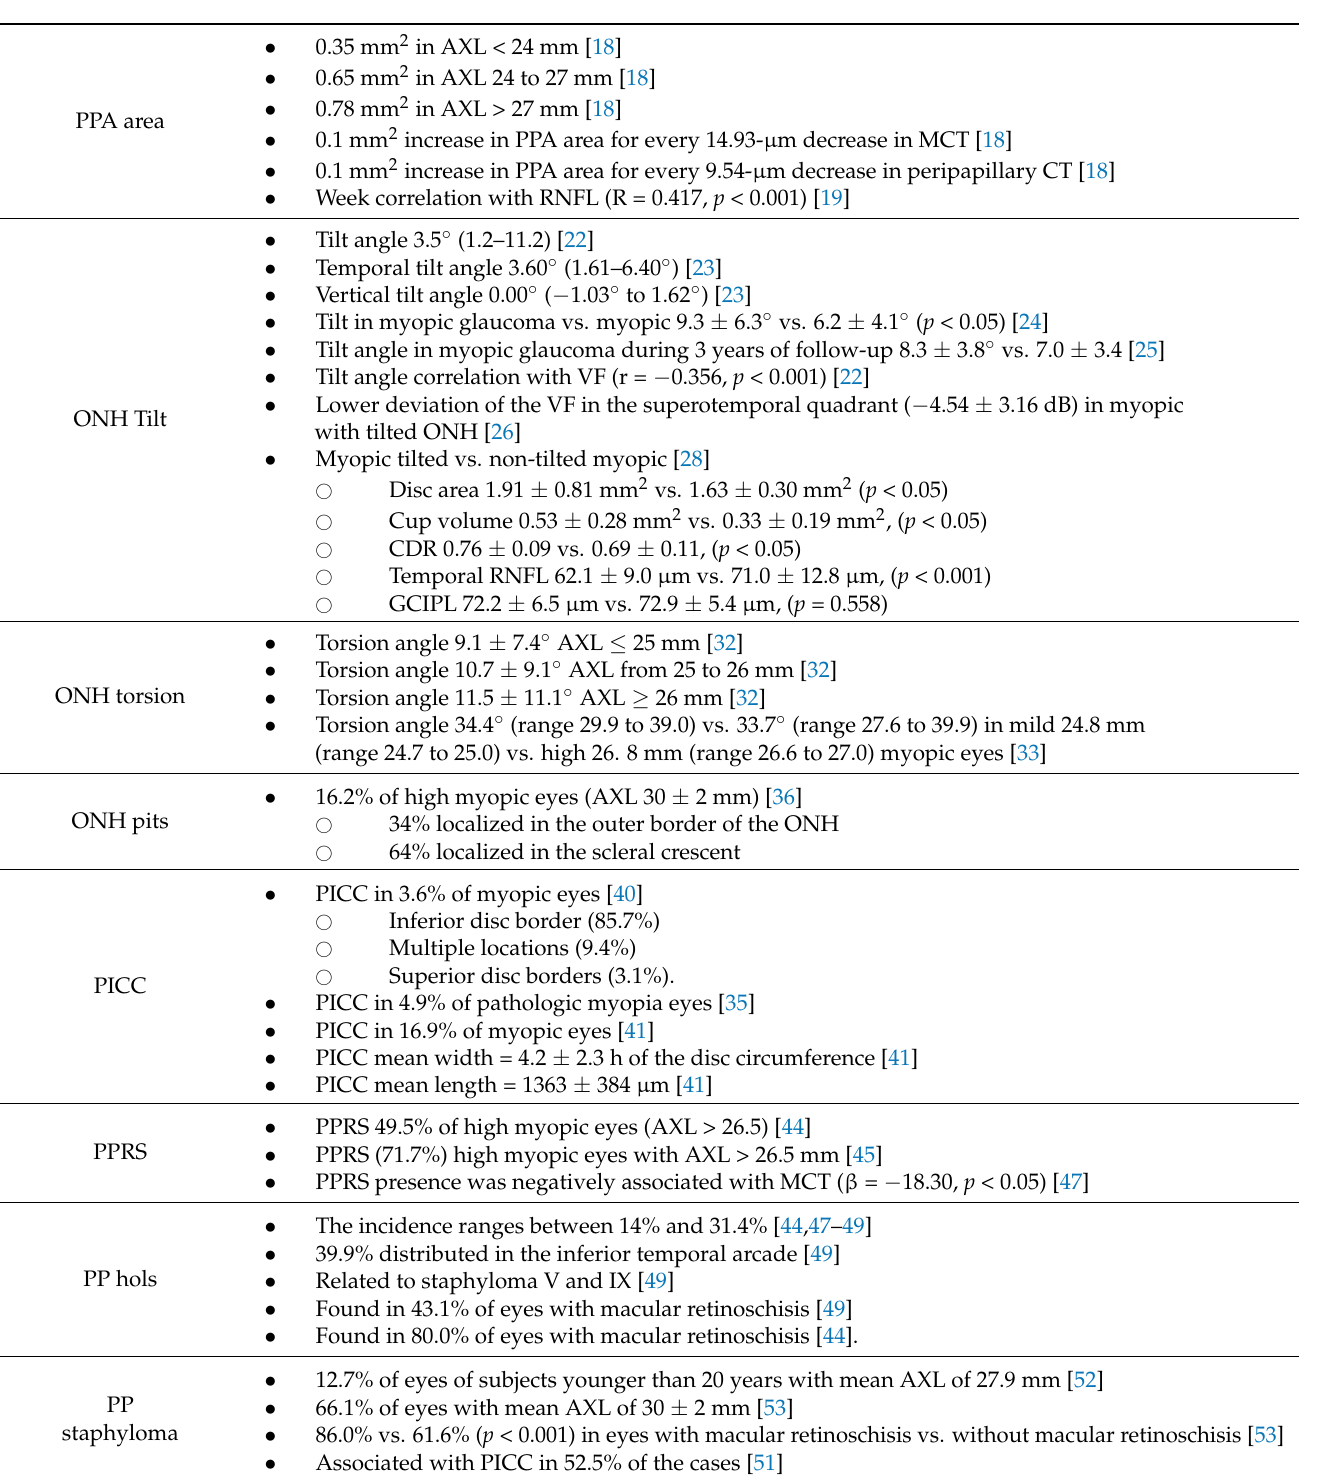
Table 2. Measurable ONH characteristics in myopic